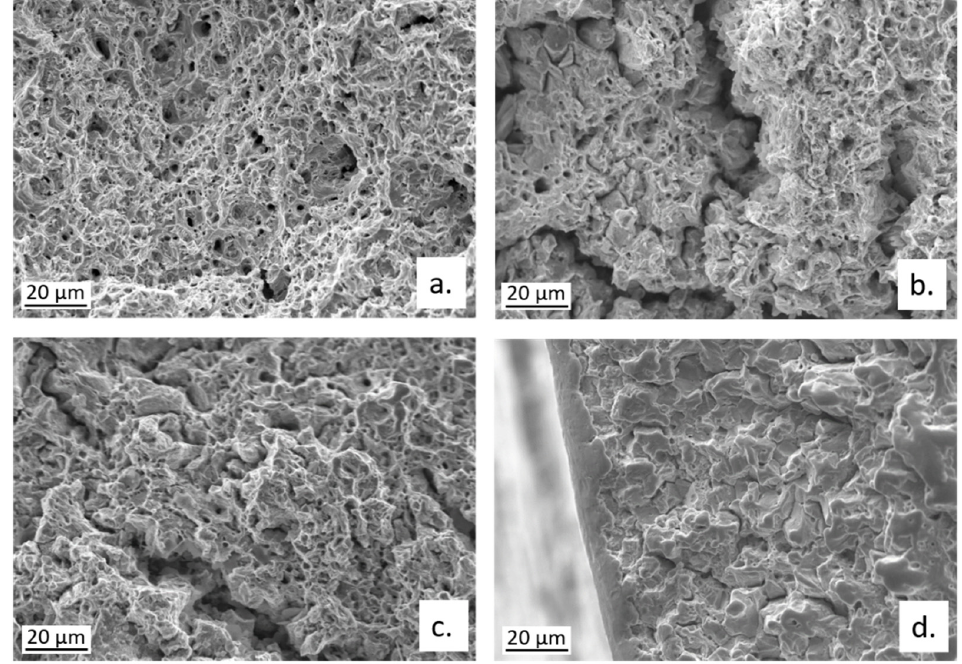
Figure 16. Fractographic analysis of CW602N tensile samples after SSRT carried out in ( a ) air or in SDW solutions containing ( b ) 100 ppm; ( c ) 400 ppm; and ( d ) 700 ppm chlorides.